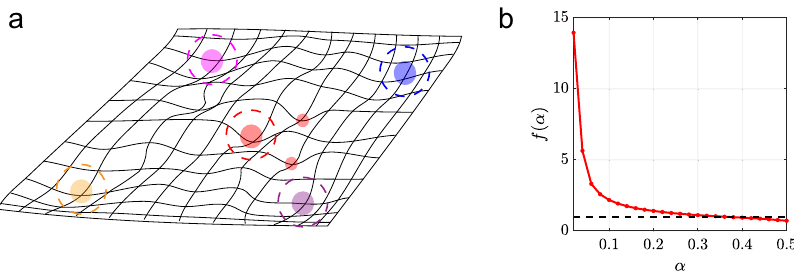
Figure 4. ( a ) schematic of the energy landscape of the memory network. The large filled circles are stored memories and the dashed circles denote their basins of attraction. The two small red circles are fixed points outside of the basin of attraction of the red memory which still lead to a large enough overlap for accurate N / L . ( b ) f (α) defined in Eq. (7) is obtained from simulations of a Pseudo-inverse network decoding when 1 ≫ 8000 . The black dotted line at 1 shows that m storing random memories of size N = parallel updates are used for memory retrieval and averages are performed over 50